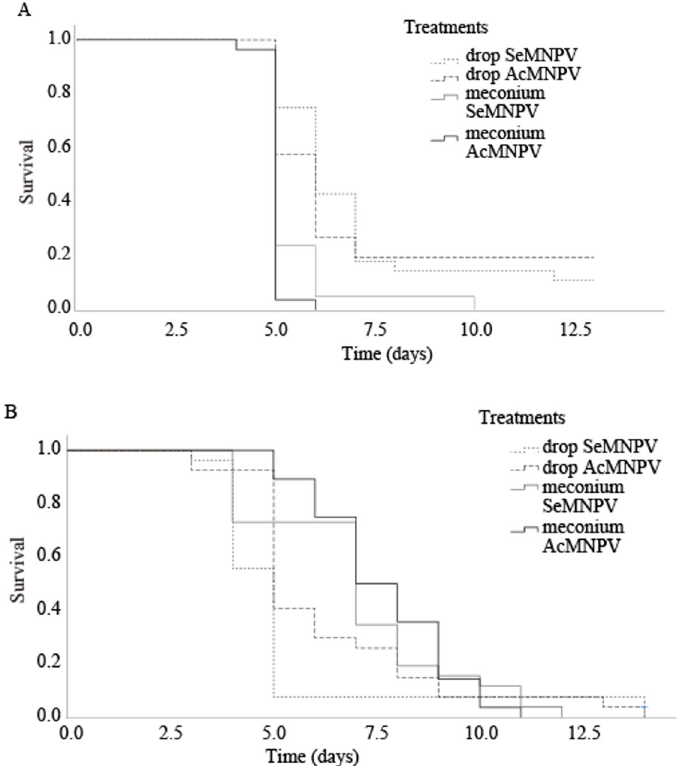
Table 2. MTD (Median Time to Death) values estimated in S. exigua second instars infected with suspensions of OBs or directly with predator’s excreta. Infected with Suspension of OBs Treatment